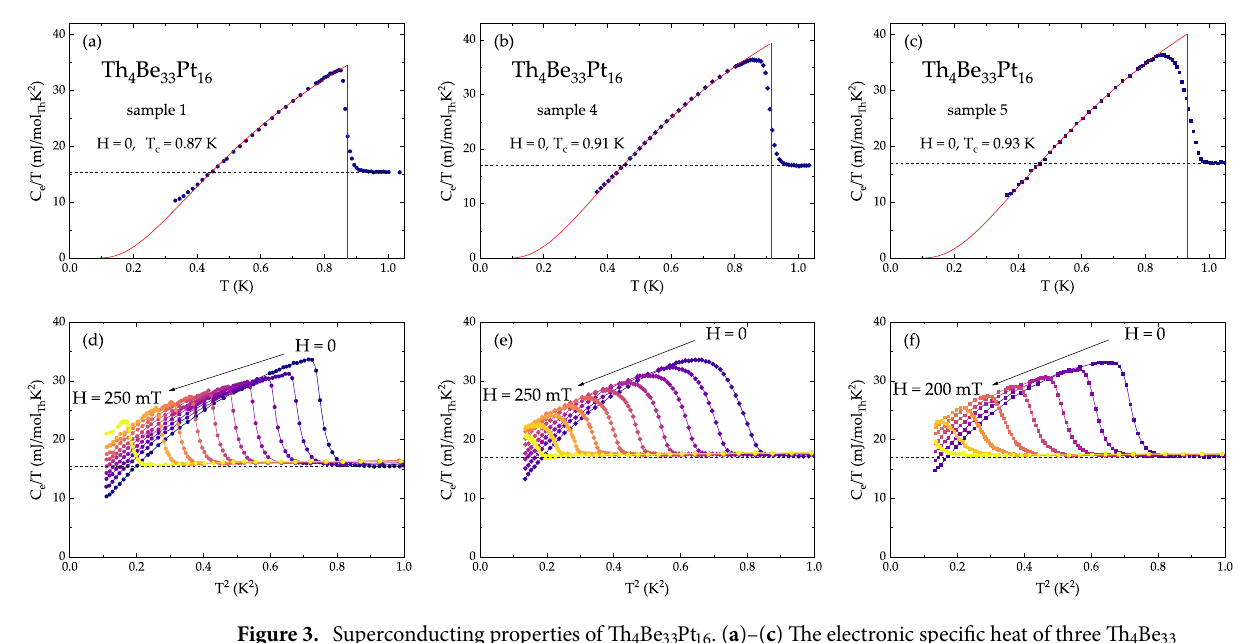
Figure 3. Superconducting properties of Th 4 Be 33 Pt 16 . ( a )–( c ) The electronic specific heat of three Th 4 Be 33 Pt 16 samples, measured in H = 0 . Note that a feature, associated with transition into superconducting state is observed around T c = 0.90 ± 0.04 K for all three samples. Vertical solid lines are equal entropy construction. The horizontal dashed line corresponds to the Sommerfeld coefficient γ n . The red curve is a fit C / T ∝ e − �/ ( d )–( f ) Temperature-dependent specific heat data, scaled by temperature, as a function of temperature squared for three Th 4 Be 33 Pt 16 samples, measured in various magnetic